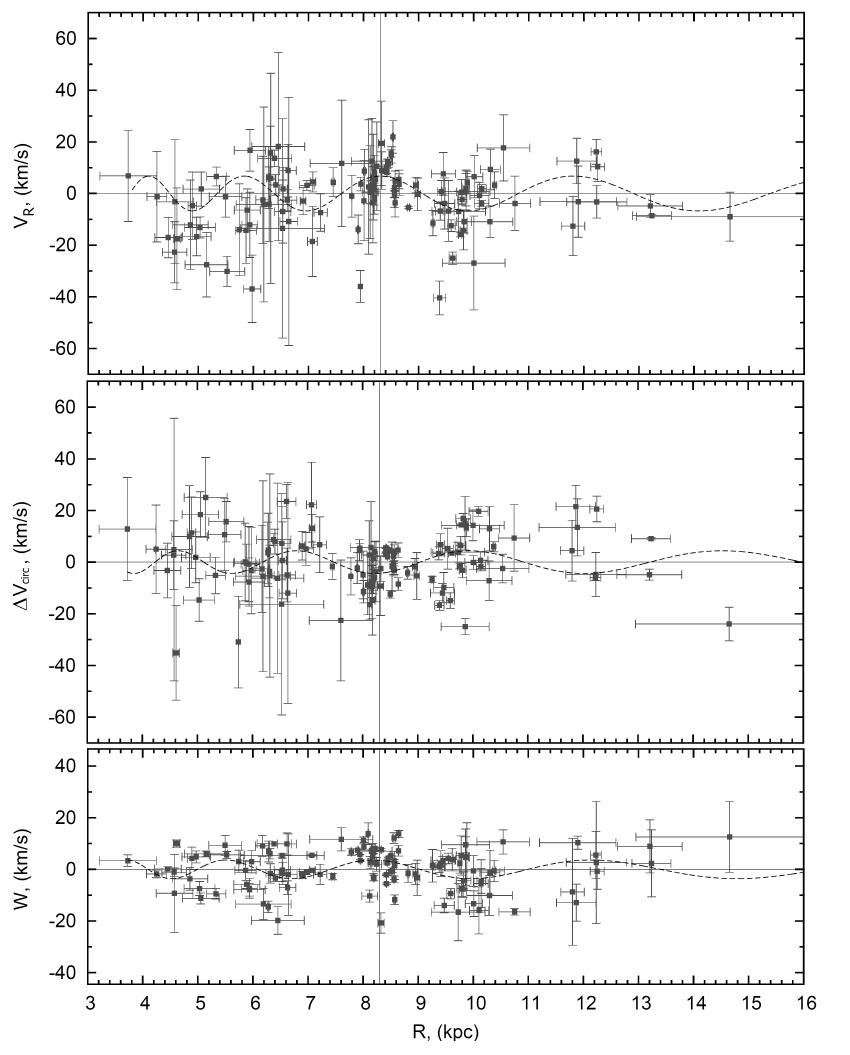
Fig. 1. The radial V R , residual tangential ∆ V circ , and vertical velocities W of masers versus distances R . The vertical line indicates the position of the